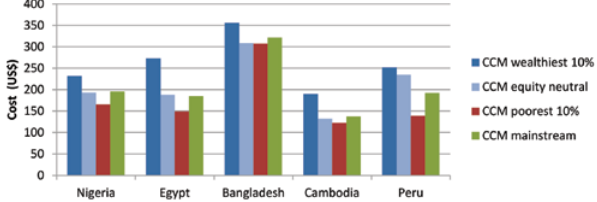
Figure 11 Estimated cost per life saved in exemplar